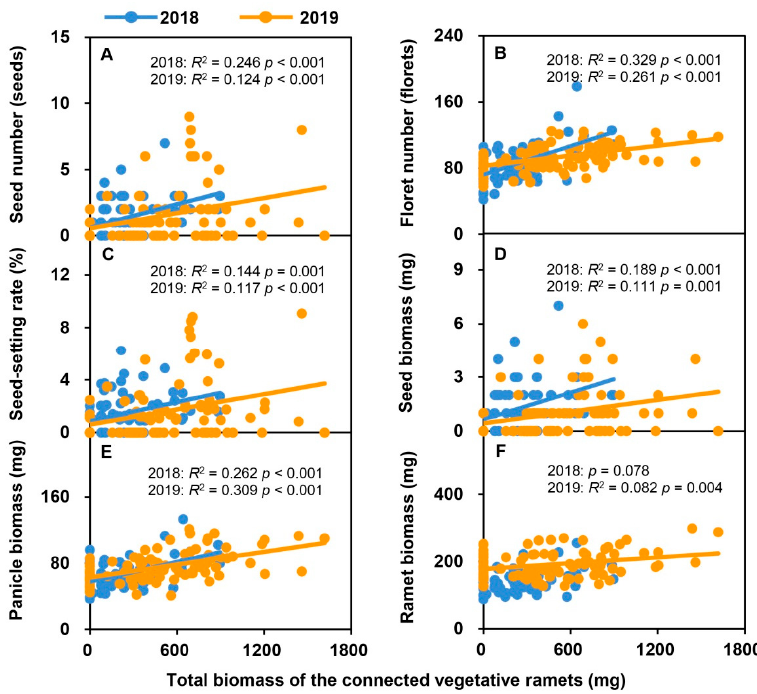
Figure 3. Relationships between sexual reproductive characteristics (seed number, ( A ); floret number, ( B ); seed-setting rate, ( C ); seed biomass, ( D ); panicle biomass, ( E ); ramet biomass, ( F )) and total biomass of vegetative ramets connected to tillering nodes in the natural populations of Hierochloe glabra over two consecutive years. The colored lines represent fitting lines in 2018 ( n = 75) and 2019 ( n = 100).